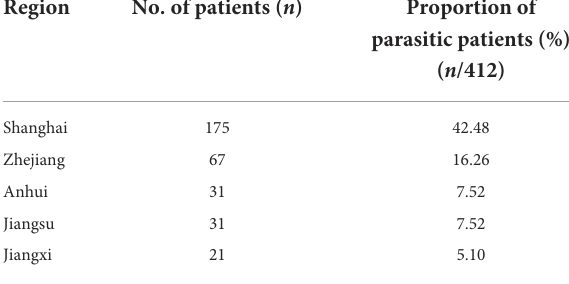
Parasite-infectedpatientsadmittedtothehospitalweremainlyfromShanghai,Zhejiang, Anhui,Jiangsu,andJiangxi.